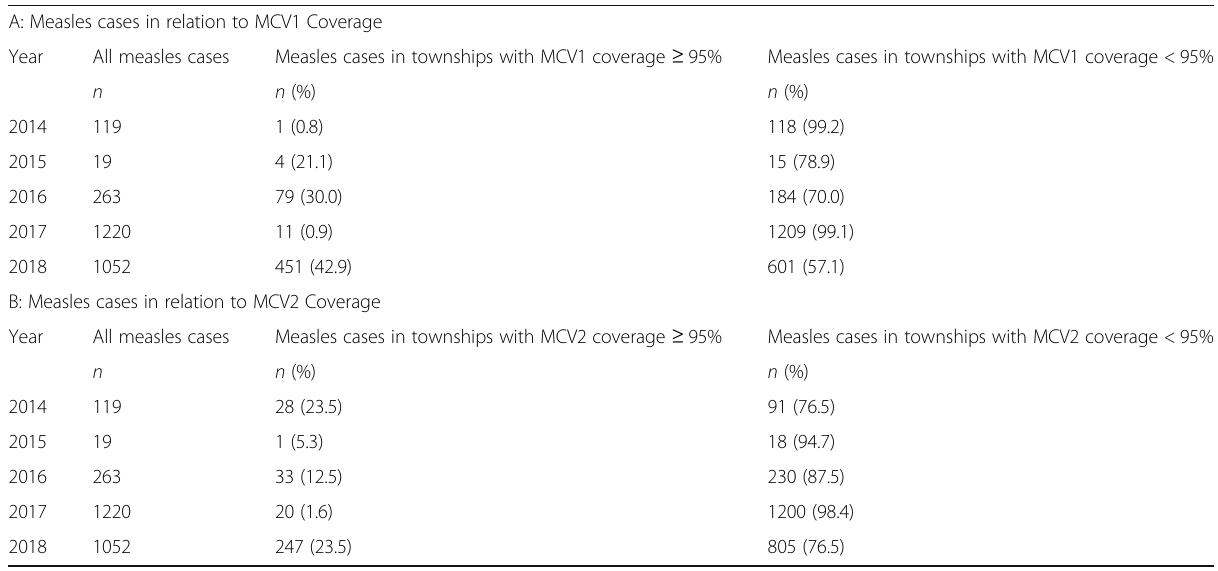
Table 4 Associations between annual reported measles cases and MCV coverage at the township level, Myanmar: 2014 to